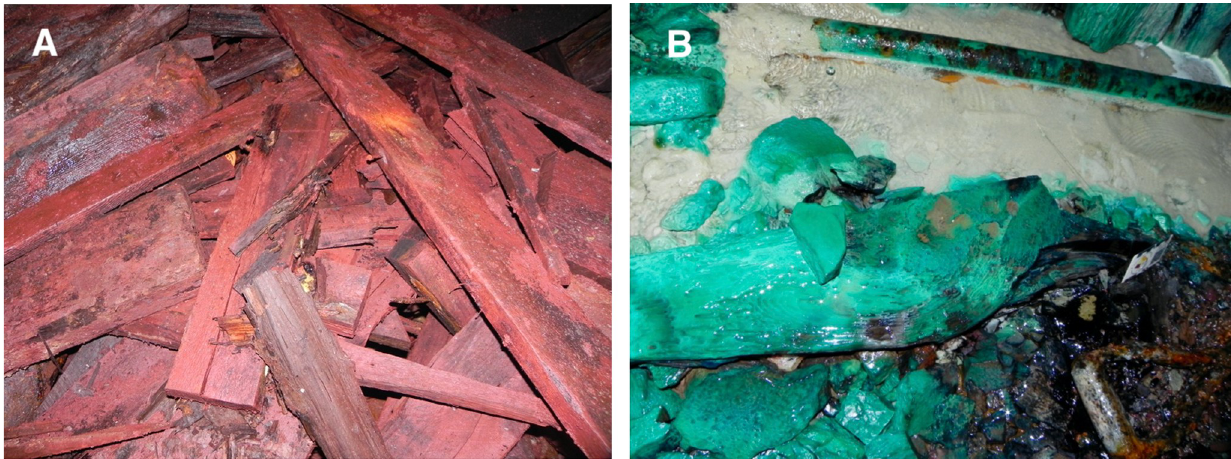
Fig 5. Examples of extensive metal deposition on wood in the Soudan mine. (A) A pile of discarded lumber coated with iron and (B) encased with a layer of copper and despite the extremely high metal concentrations, fungi such as Cadophora species were isolated from these substrates.